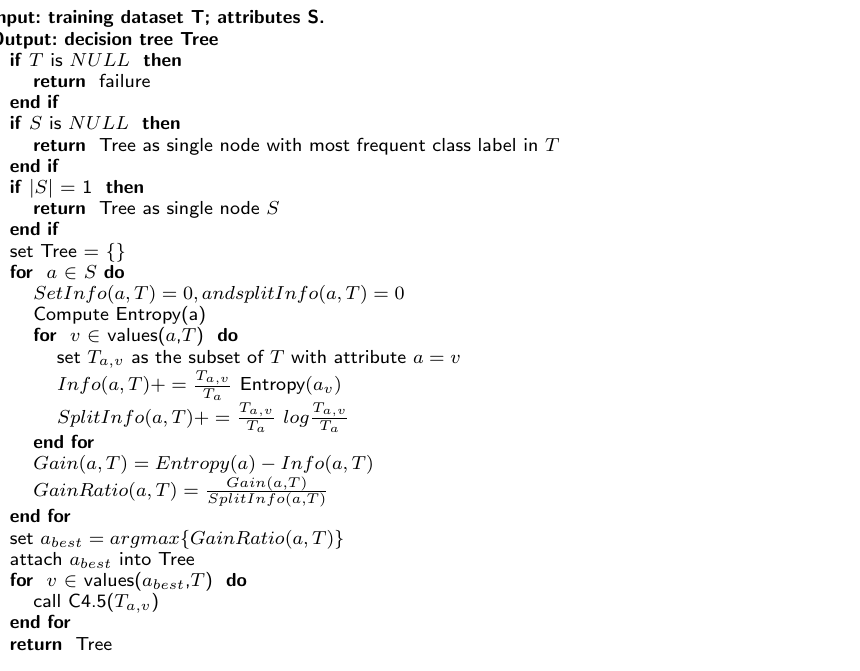
Algorithm 1 DT algorithm